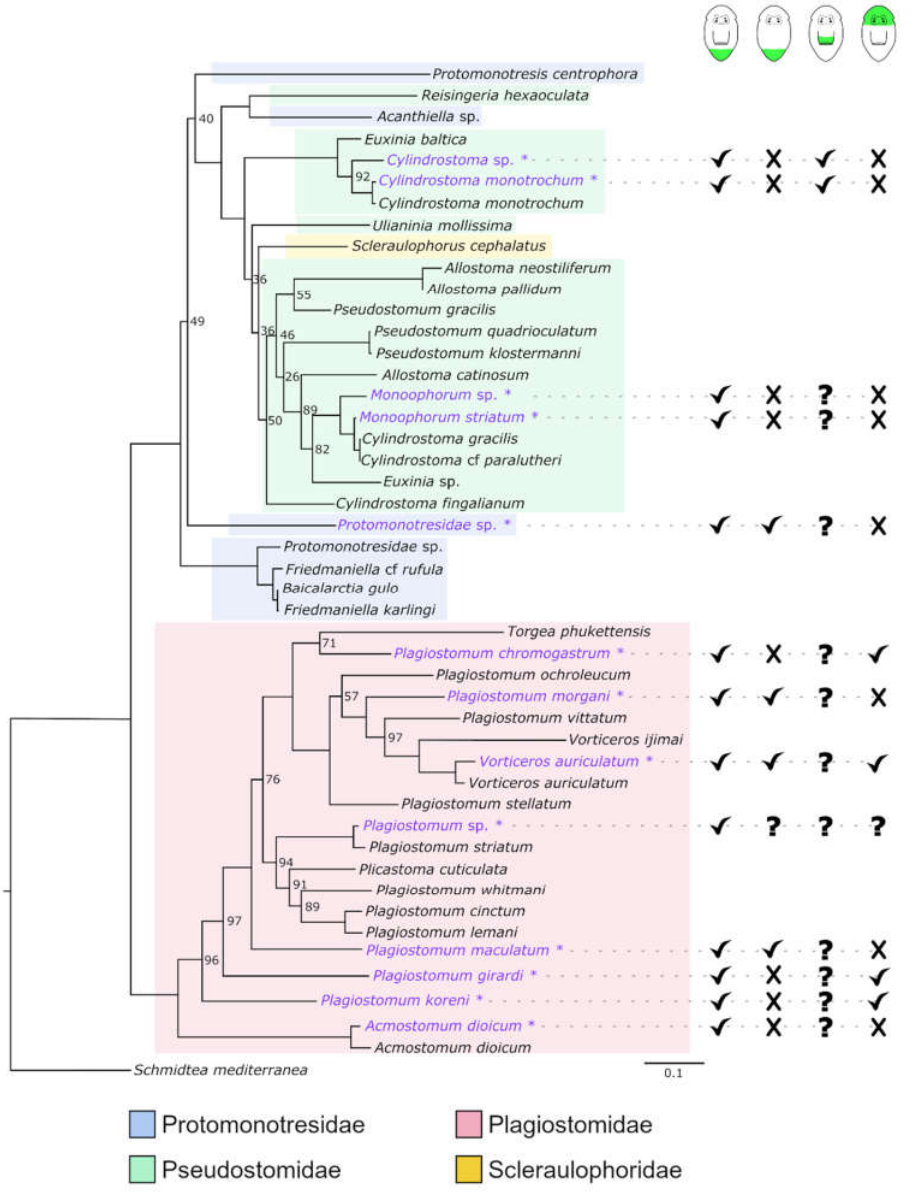
Figure 14. Maximum-likelihood reconstruction of Prolecithophora from partial 18S and 28S sequences, rooted with the triclad Schmidtea mediterranea . New sequences provided in this work are written in purple. Node numbers indicate bootstrap (bs) support values, bs support of 100 is omitted. Current classification in families is indicated by a coloured background; note that Protomonotresidae and Pseudostomidae do not appear to be monophyletic. Overall regeneration capacity as found in this study is indicated with check marks (=present), cross marks (=not present) or question marks (=not studied) for four categories (from left to right): (1) posterior regeneration takes place when the pharynx is present, (2) posterior regeneration takes place also in the absence of the pharynx, (3) parts of the pharynx can regenerate, and (4) parts of the head, including parts of the brain, can regenerate. Analysed species are marked with an asterisk.